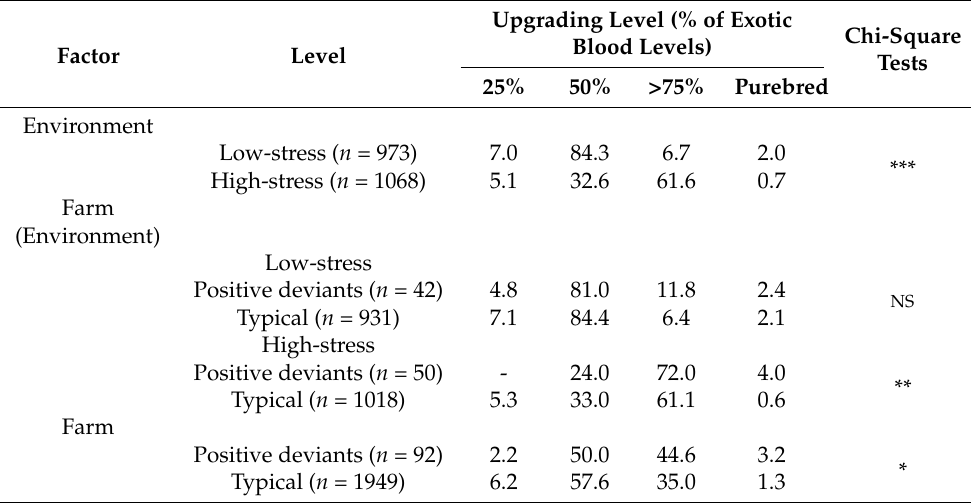
Table 4. Animal distribution frequency (percentage) by upgrading levels in positive deviant and typical farms under contrasting stressful